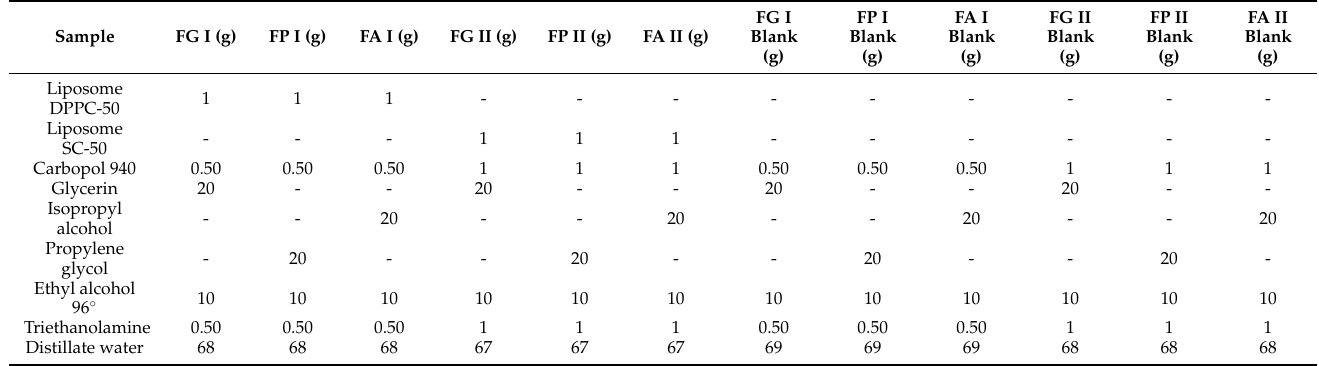
Table 1. Quantities of substances used for the preparation of liposomal